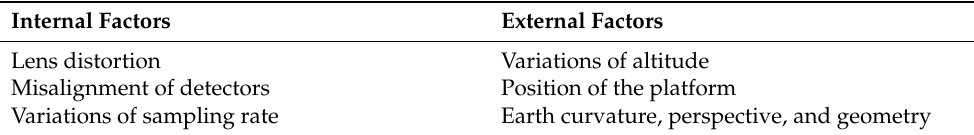
Table 8. Classification internal and external factors cause geometric distortion in image data.